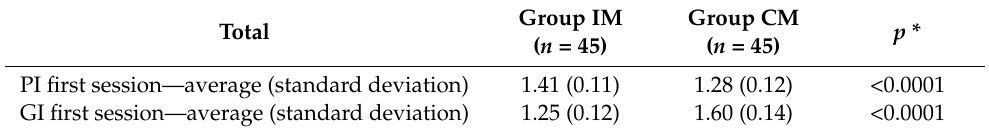
Table 6. Average (standard deviation) of PI and GI in the first monitoring session in all patients.